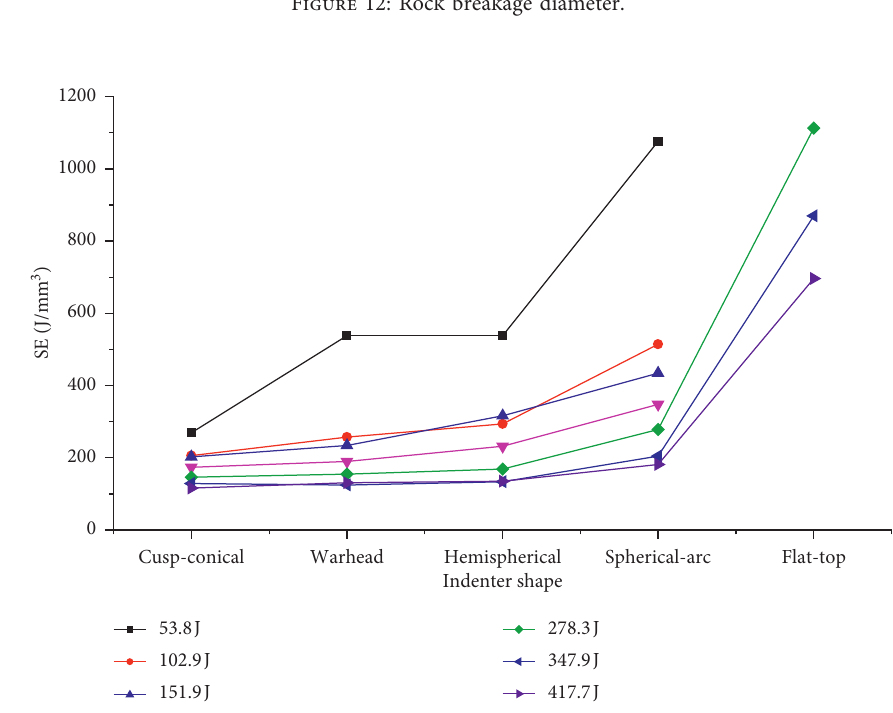
Figure 12: Rock breakage diameter.